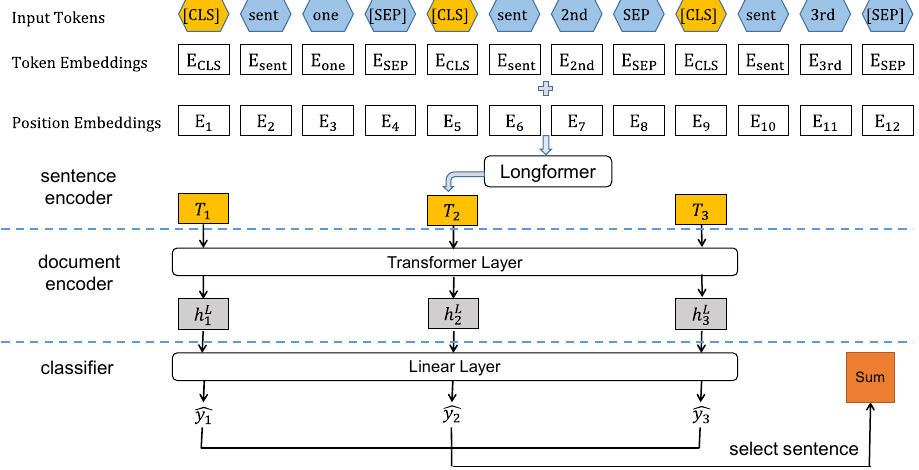
Figure 1. Long-Trans-Extr model structure.